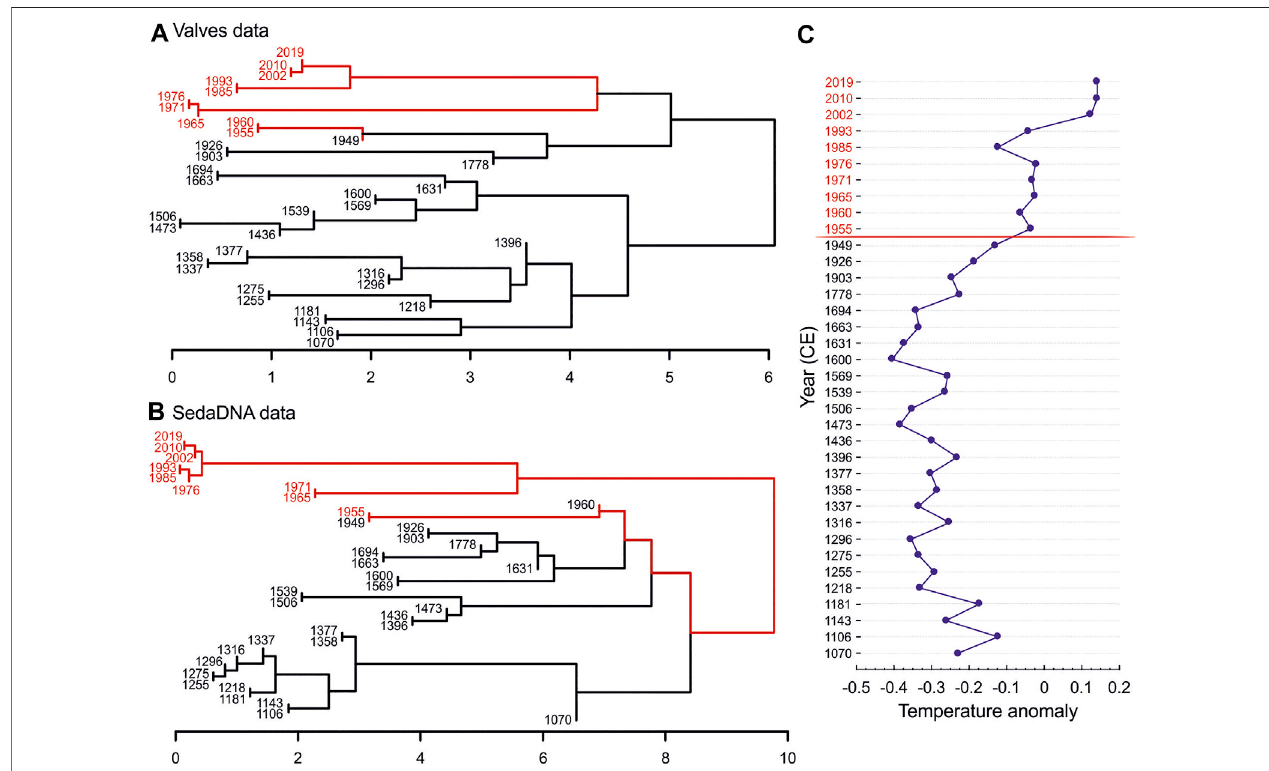
FIGURE 3 | Constrained hierarchical clustering for valves (A) and sedaDNA (B) data. Numbers at the branch tips represent years (CE), weighted mean ages of the analyzed core layers ( Supplementary Table S2 ). Branches in red and black denote the two groups identi fi ed by the multivariate regression tree (MRT) analyses. Panel (C) represents a scatter plot for the reconstructed temperature records (Mann and Jones, 2003; Collins et al., 2013; see Methods ) per sample (i.e., year CE) where the red line between 1949 and 1955 denotes the breaking point detected by MRT analysis.